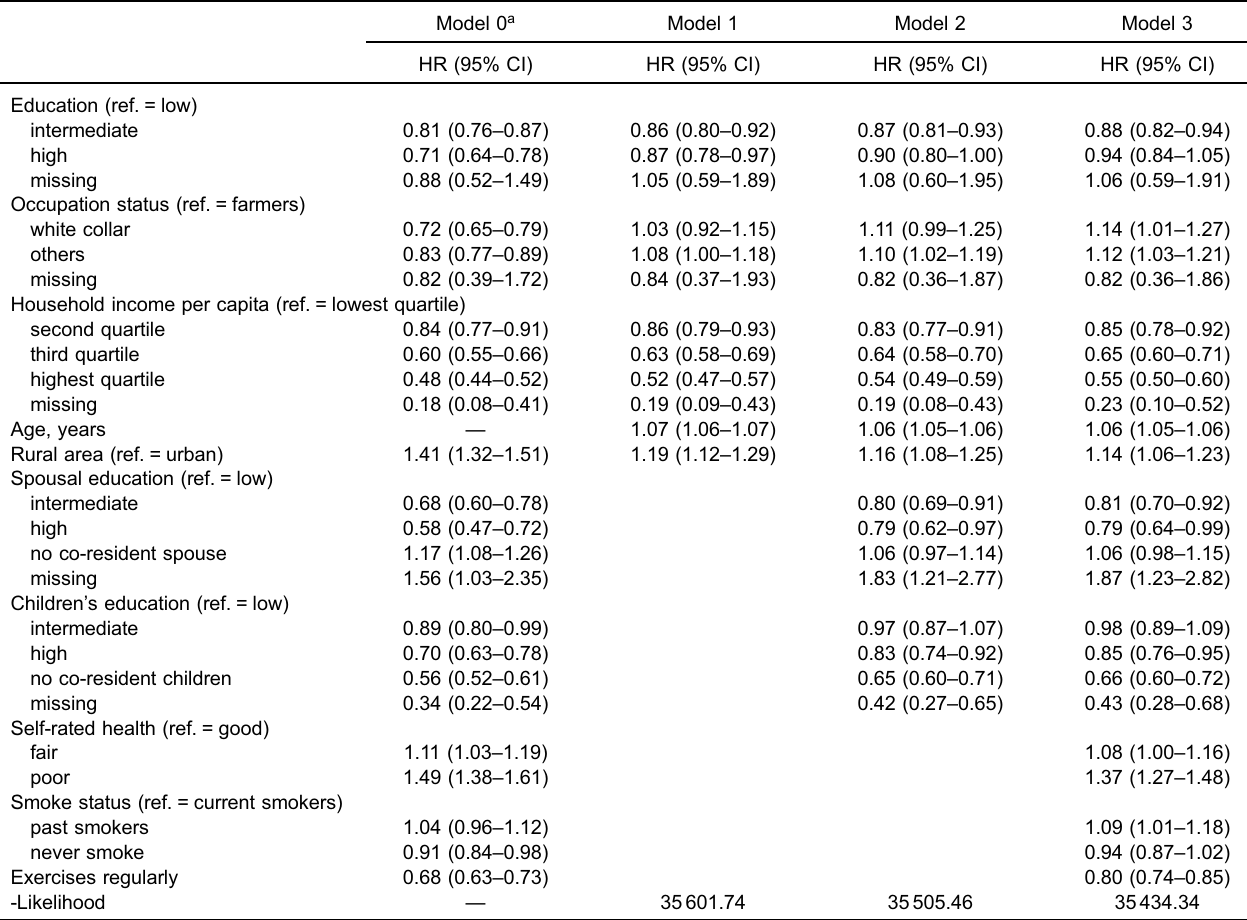
Table 2. Hazard ratios and 95% con fi dence intervals from Cox proportional model for males ( n =